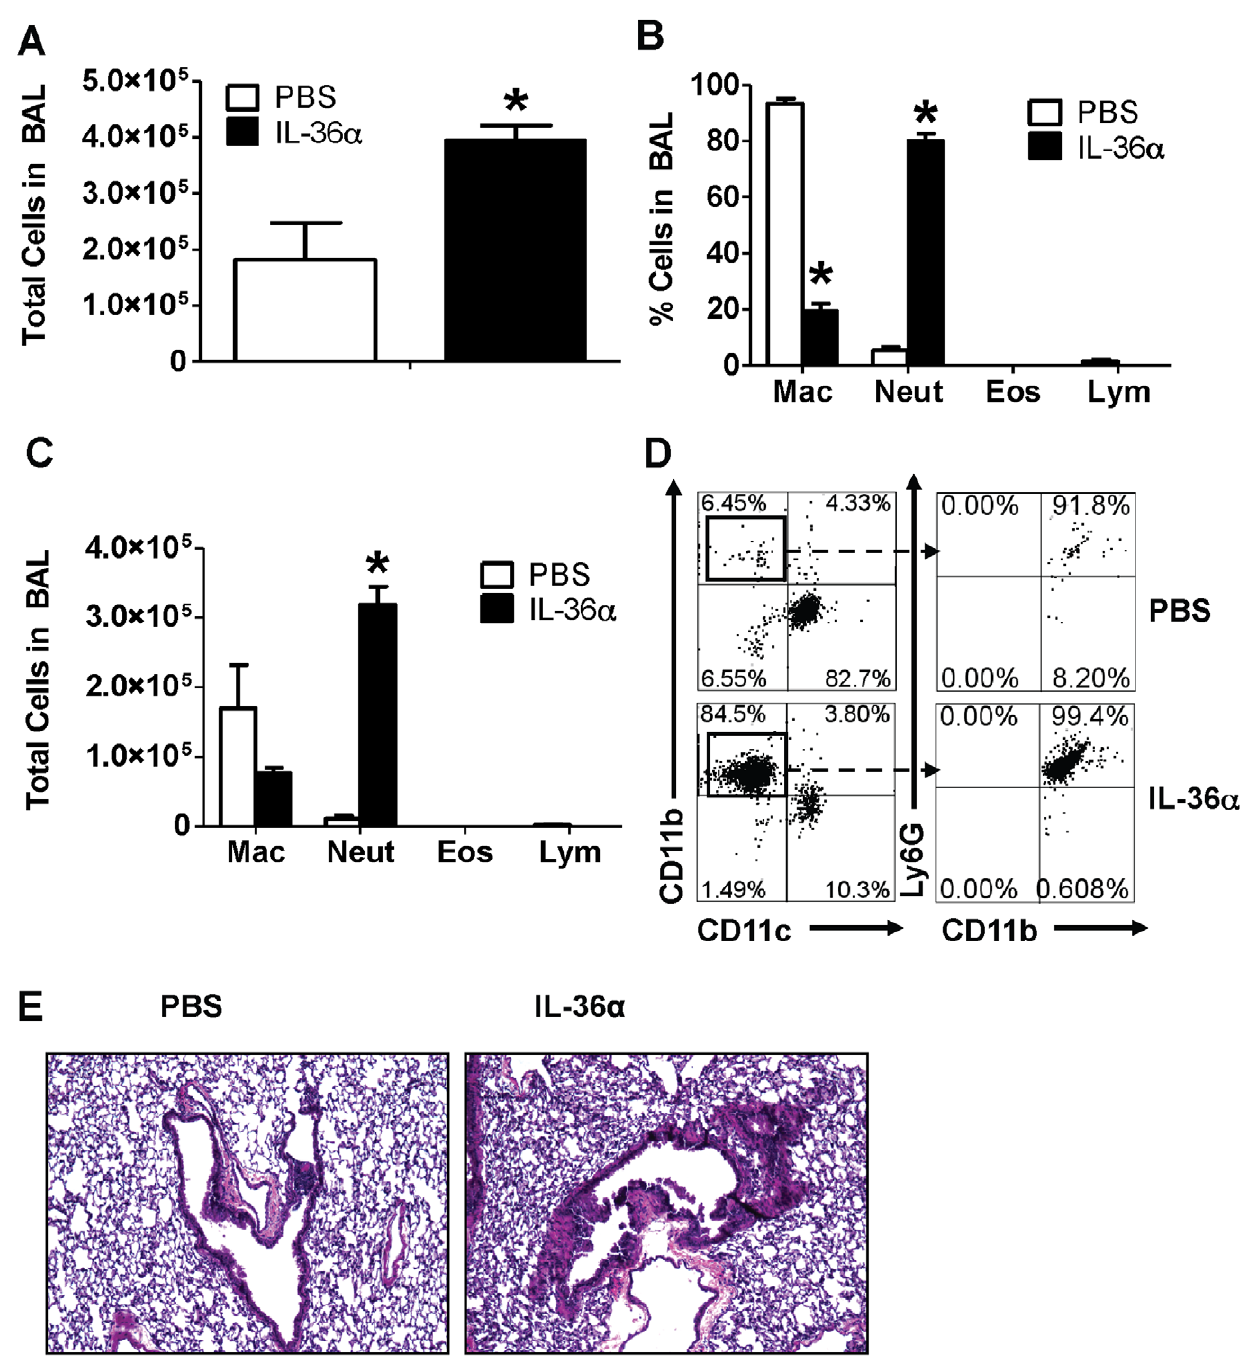
Figure 4. Intratracheal instillation of IL-36 a induced neutrophil influx in the lungs of IL-1 ab 2 / 2 mice. A) Total cell counts from BAL fluid recovered from mice 24 h following a single i.t. instillation of PBS or 10 m g IL-36 a . B) Differential cell count percentages and C) Differential cell count numbers in the BAL fluid recovered from mice 24 h following a single i.t. instillation of PBS or 10 m g IL-36 a . *Indicates significant differences ( P , 0.05 ) compared to PBS treated mice. Data represent mean 6 SEM from 3–4 mice/group. D) Flow cytometry on cells recovered from BAL fluid from mice 24 h following a single i.t. instillation of PBS or 10 m g IL-36 a . A majority of cells from the IL-36 a instilled lungs were CD11c 2 CD11b + Ly6G + neutrophils. Depicted flow cytometry plots are representative of 3–4 mice/group. H) Hematoxylin & Eosin stained lung sections isolated from mice 24 h following a single i.t instillation of PBS or 10 m g IL-36 a . Depicted sections are representative of 3–4 mice/group.